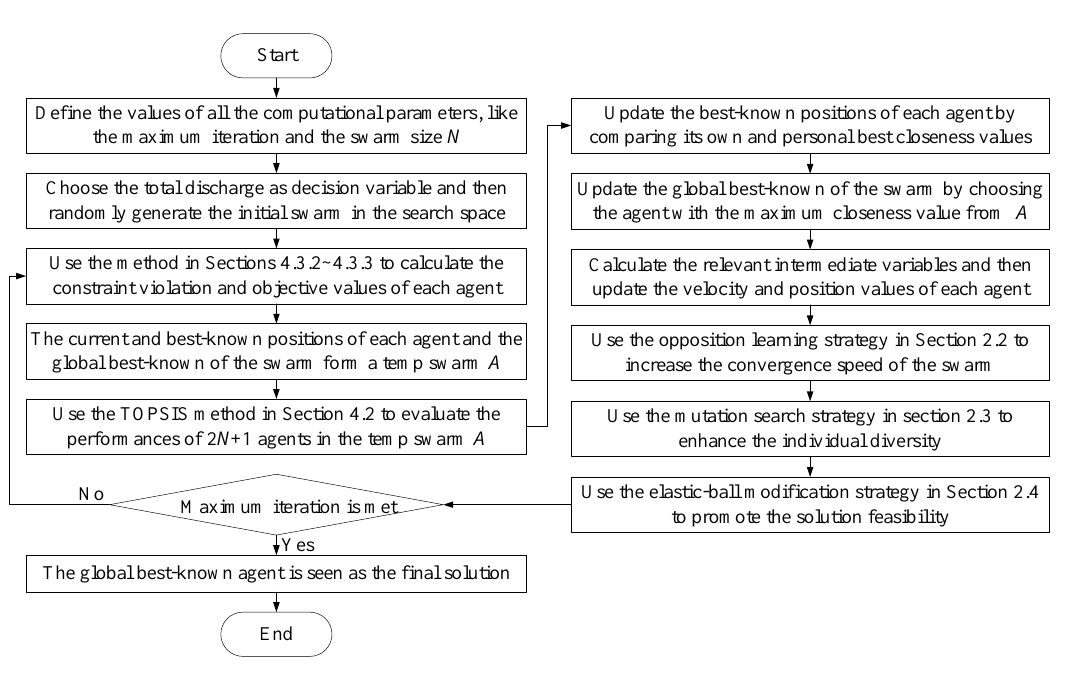
Figure 4. The flowchart of enhanced gravitational search algorithm (EGSA) for multi-objective operation of cascade hydropower reservoirs.